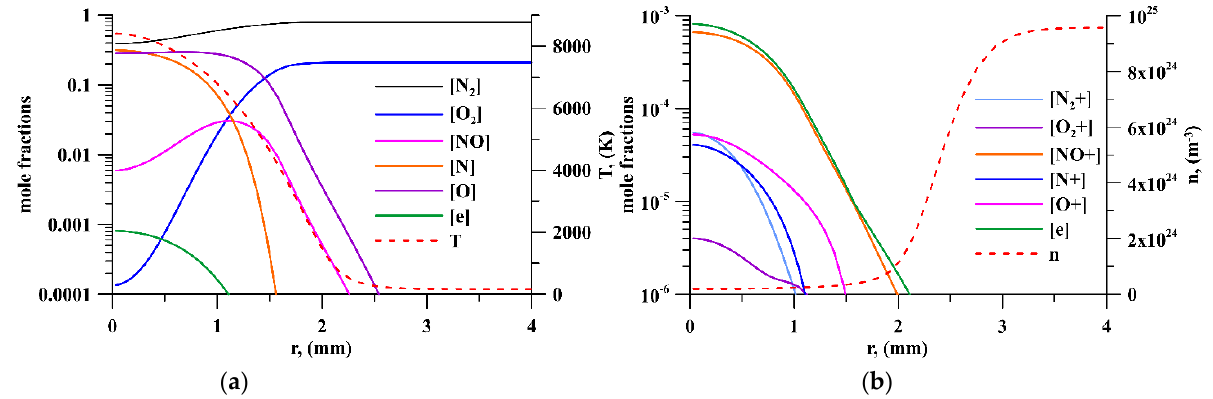
Figure 12. Distributions of neutral ( a ) and charged ( b ) components, as well as the temperature and concentration for the cross-section (35 mm) and current (5 A).